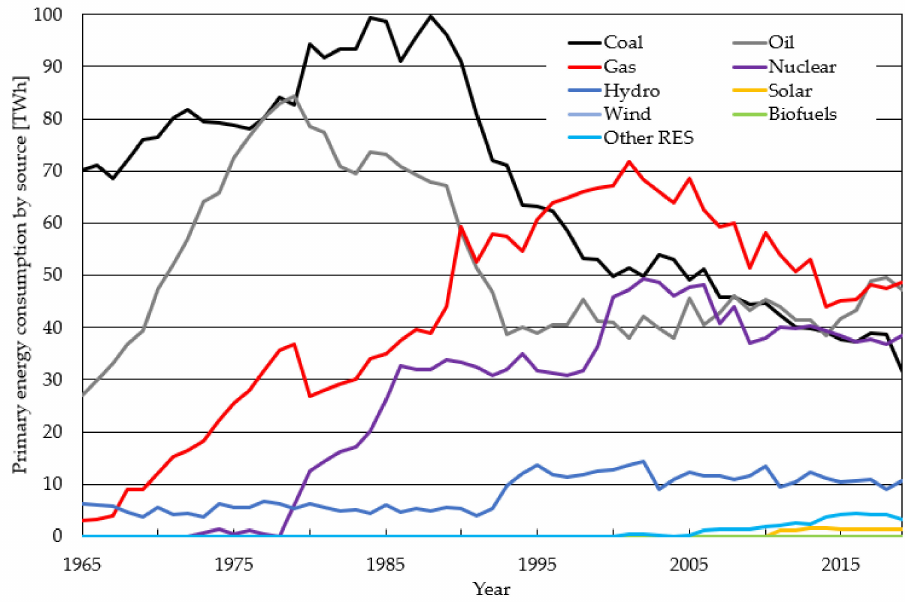
Figure 6. Historical development of primary energy consumption of the Slovak Republic (1965–2019)